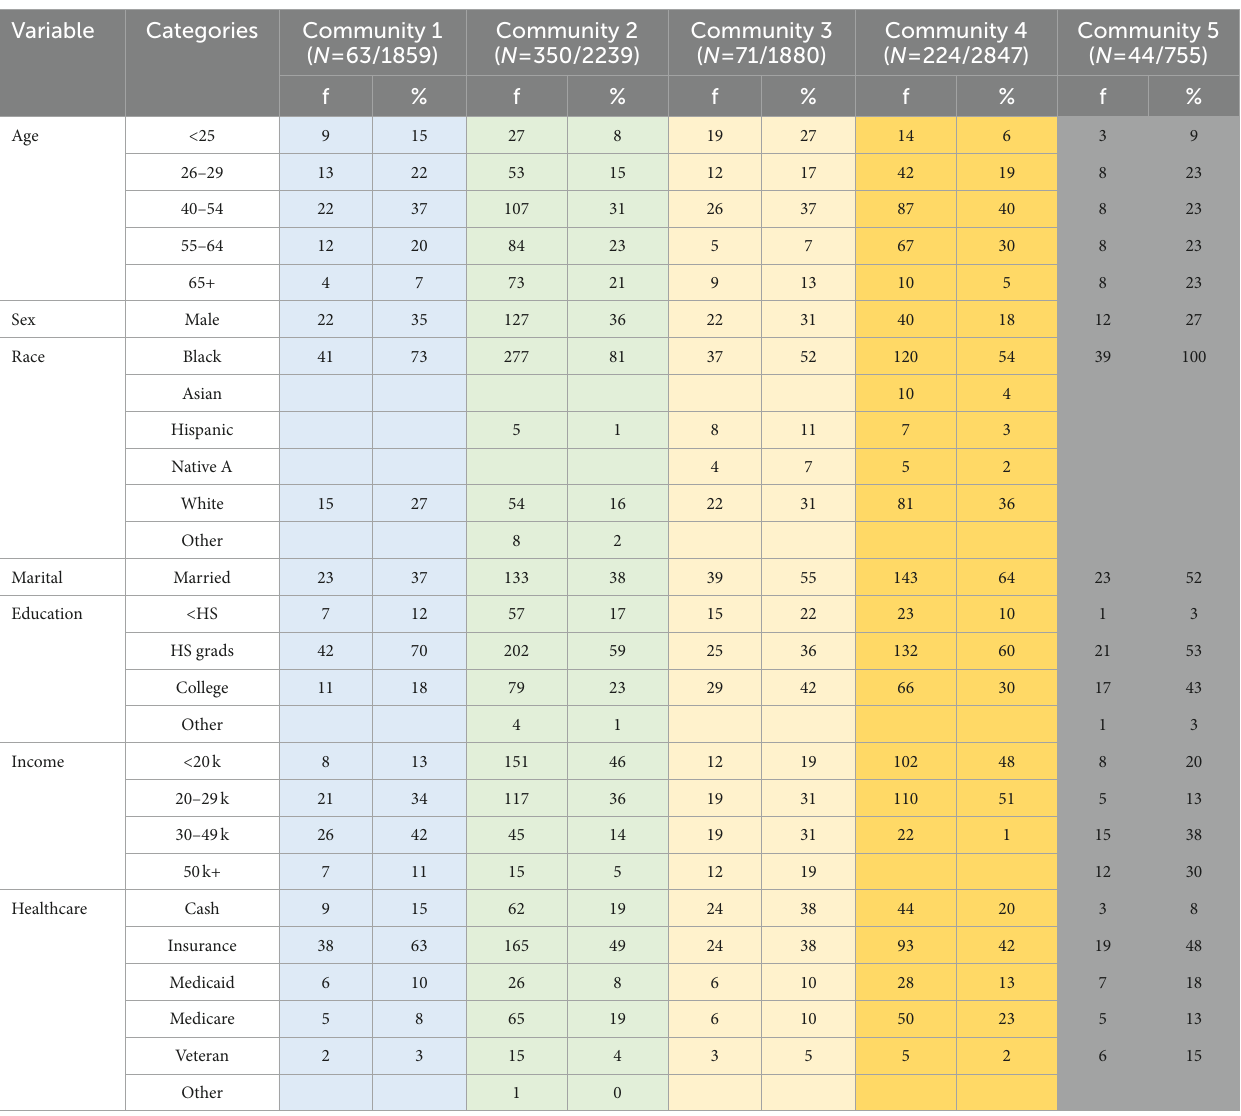
TABLE 2 Demographics of the study